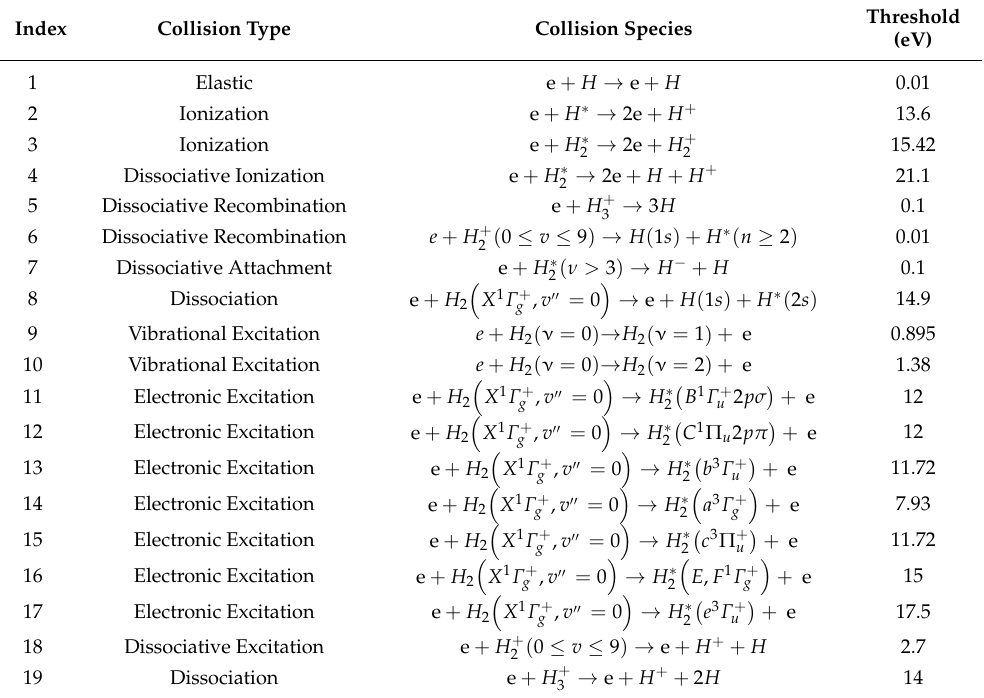
Table 2. Reaction in the transport simulation